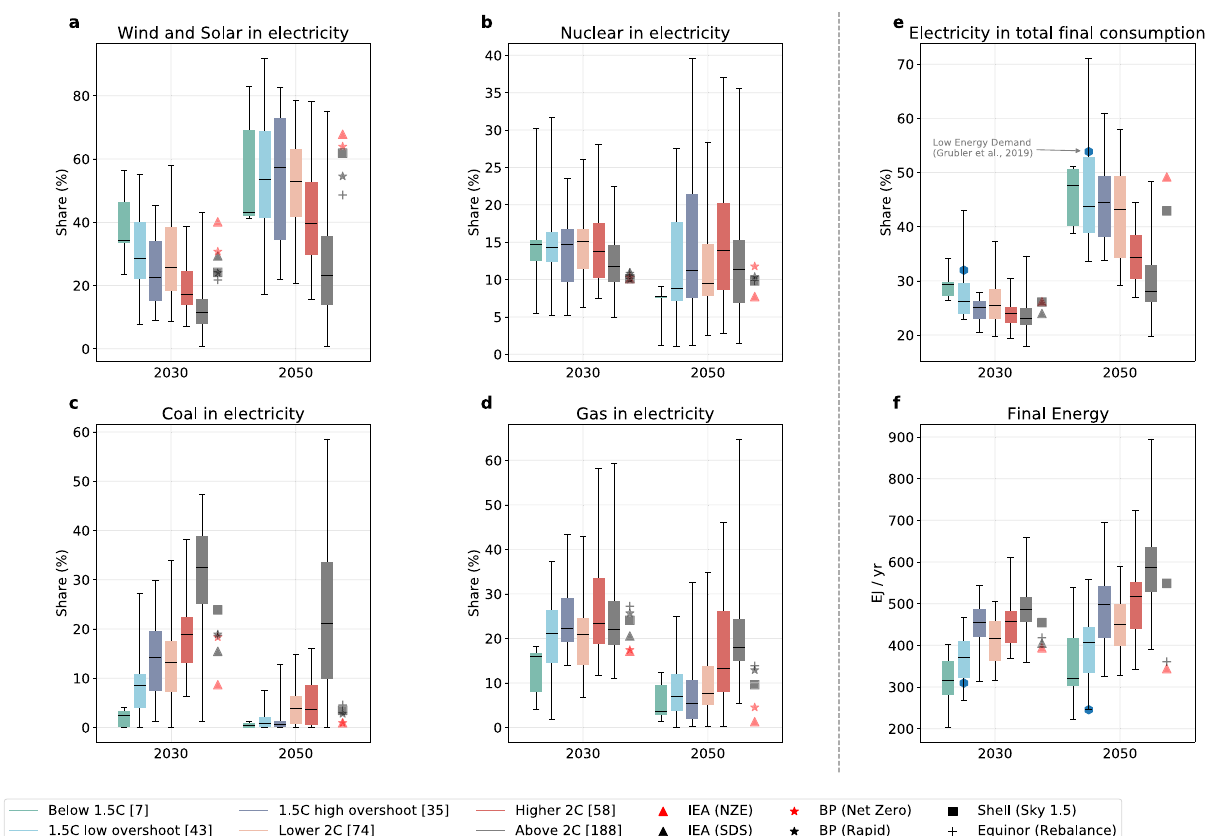
Fig. 4 Key energy system characteristics across pathways. The dashed vertical line separates two groups of indicators. Panels ( a – d ) are focused on the share of different fuels and/or technologies in total electricity generation. Panels ( e , f ) capture total fi nal consumption, and the electri fi cation of end-use. a Share of wind and solar in electricity generation. b Share of nuclear in electricity generation. c Share of coal in electricity generation. d Share of natural gas in electricity generation. e Share of electricity in total fi nal consumption. f Total fi nal energy consumption. The numbers in parentheses refer to the number of IPCC ’ s Special Report on 1.5 °C (SR1.5) database scenarios of each category. Where a speci fi c scenario is missing in the panel (for instance, in panel e ), it is either because the data are not reported, or, in the case of the International Energy Agency ’ s (IEA) Sustainable Development Scenario (SDS) from 2020, because the scenario ends in